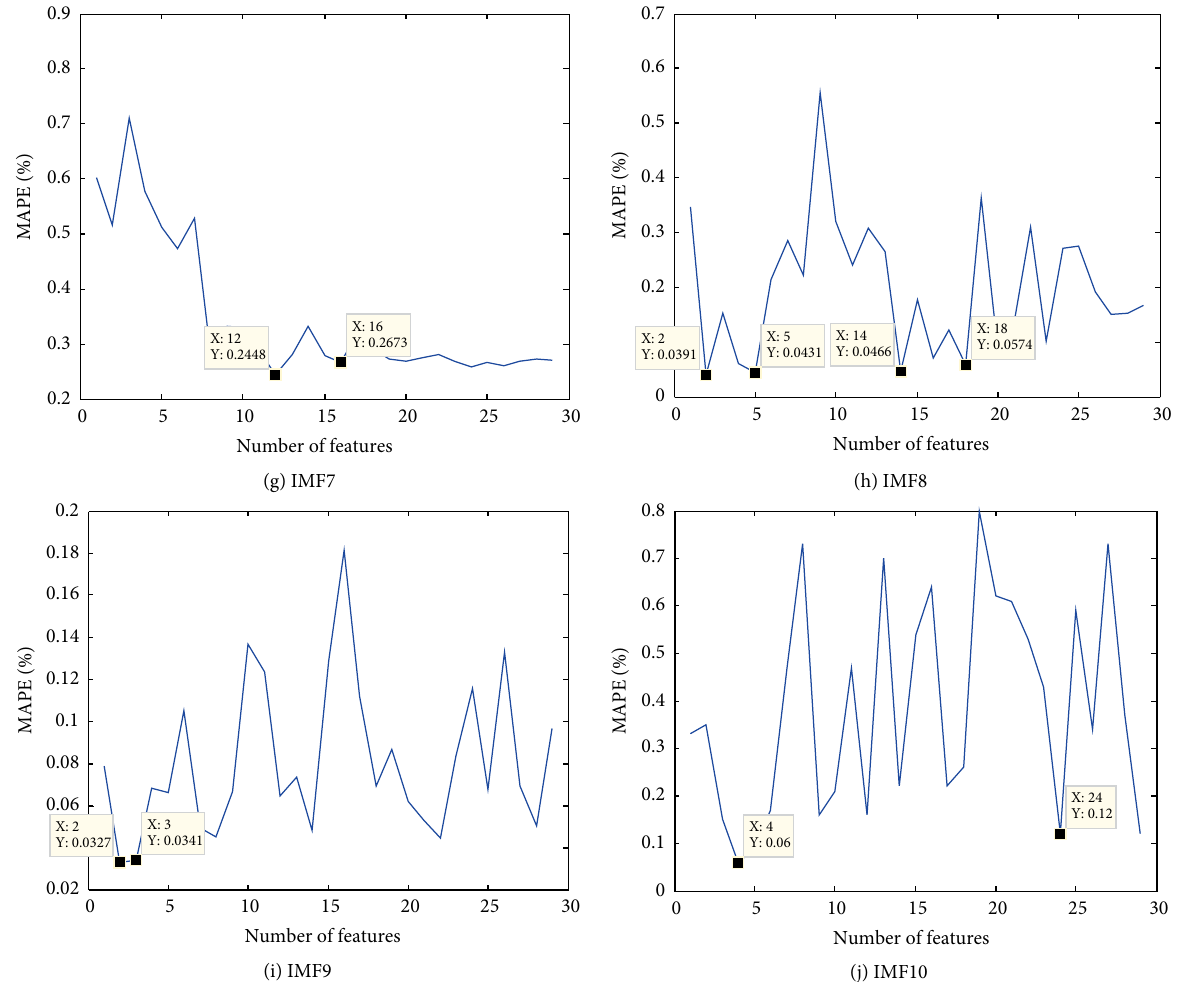
Figure 7: Relationship between the input number and error of each component feature. Table 5: The number of each component input features and their names. The number Component of